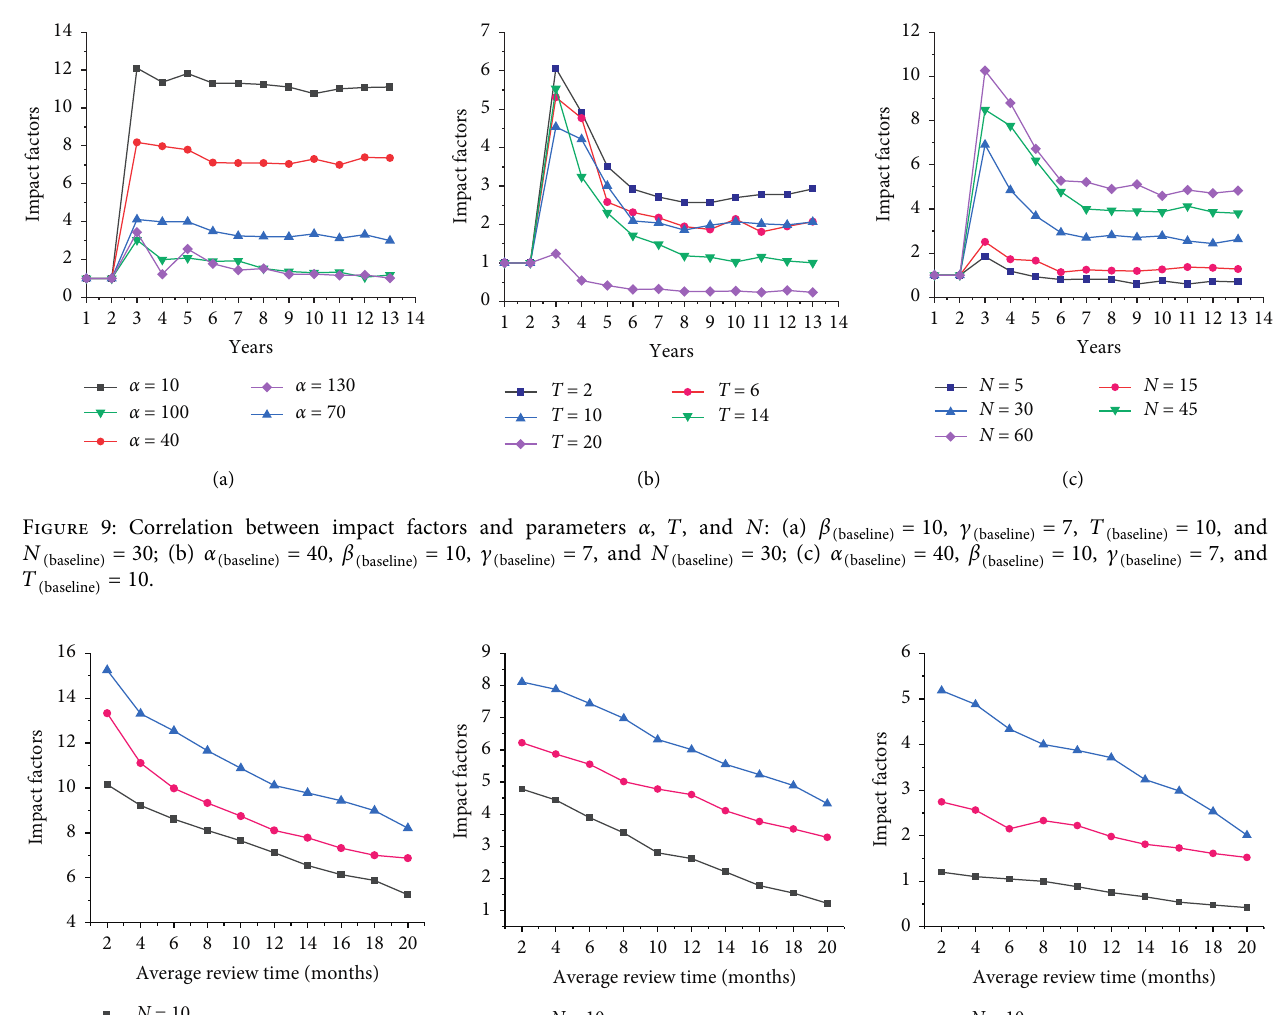
� 10, β � 5, and c � 2; ( min ) ( min ) ( min ) � 10. ( max )